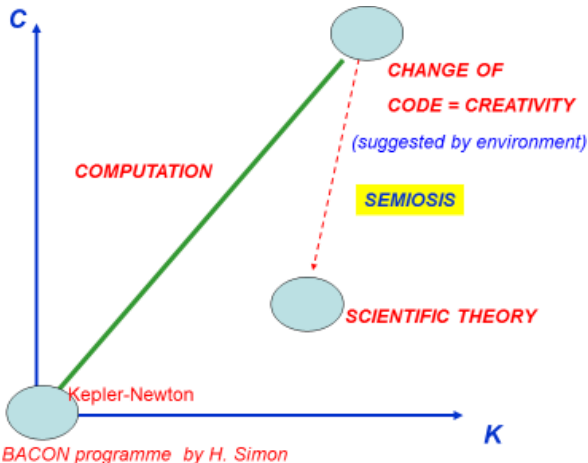
Figure 17. Normal science vs. paradigm shift  effective science [Hartmann, Kuhn]. Let C be the bit length of the algorithm and K the Kolmogorov entropy, i.e., the inverse of the time t beyond which the initial information is lost by dynamical chaos. A com- puter program that evaluates Kepler’s orbits, as BACON, has small C and K . As the physical system gets richer, both C and K increase and a scientific search carried on by an AI system would be affect- ed by higher and higher C and K . However, a linguistic actor as a human scientist can act by a “jump of paradigm”, that is, change code and introduce a new scientific theory (effective description) with low C and K .